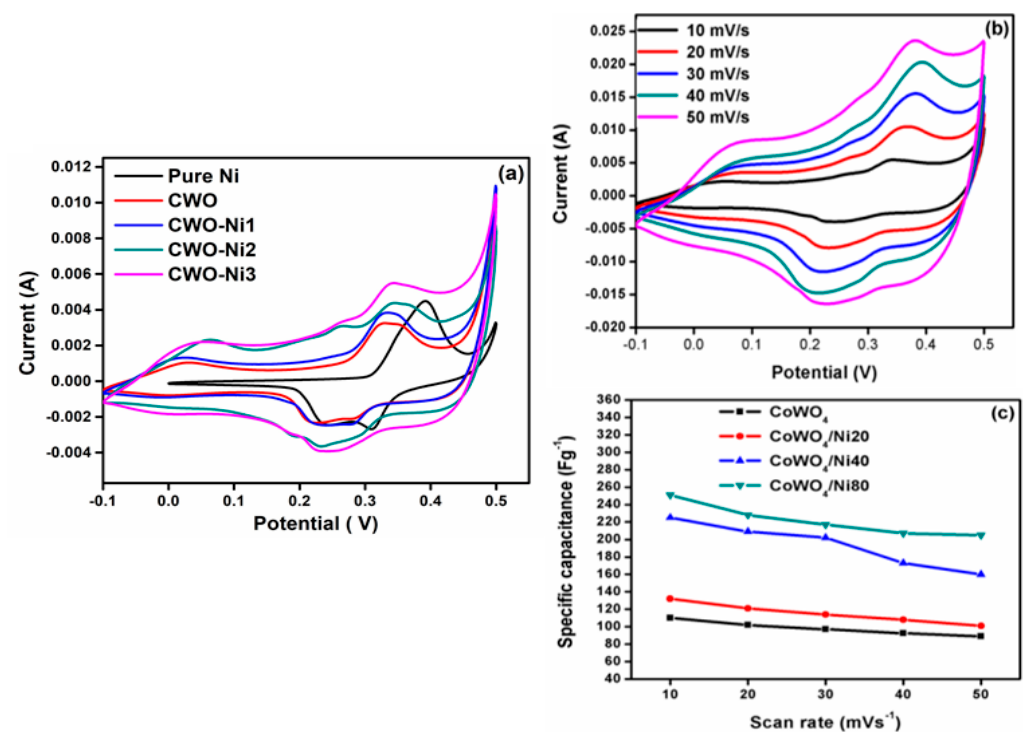
Figure 5. ( a ) Comparison of the cyclic voltammetry (CV) plots of pure Ni, CWO, CWO–Ni1, CWO–Ni2, and CWO–Ni3; ( b ) CV curves of CWO–Ni3 at scan rates ranging from 10 to 50 mV s − 1 ; ( c ) comparison of the specific capacitance (SC) values of CWO, CWO–Ni1, CWO–Ni2, and CWO–Ni3 at different scan rates.